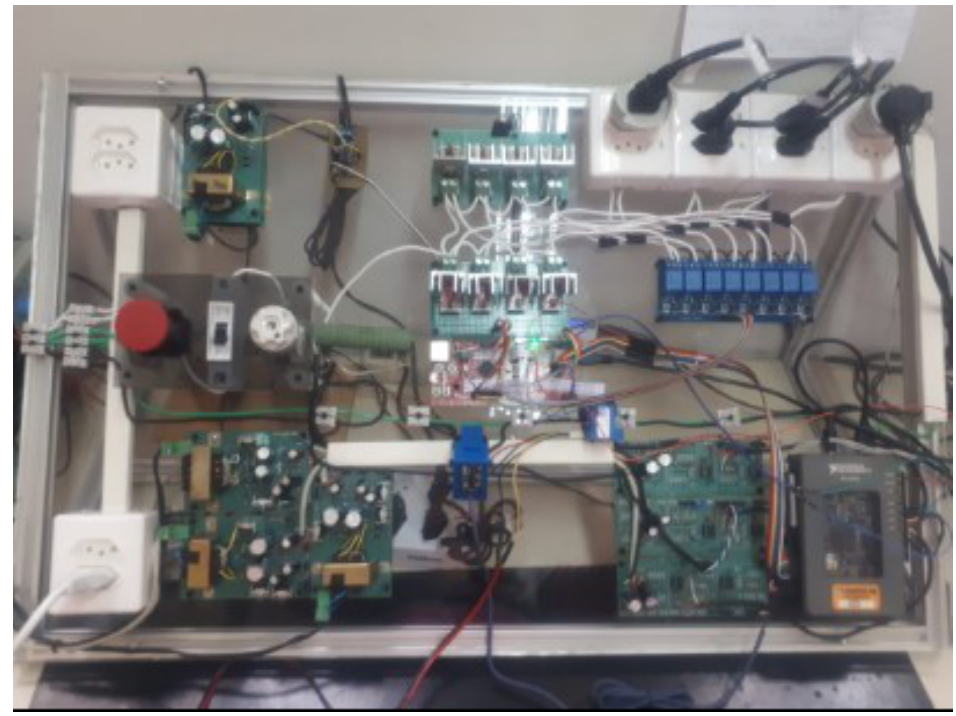
Figure 2. Data collecting